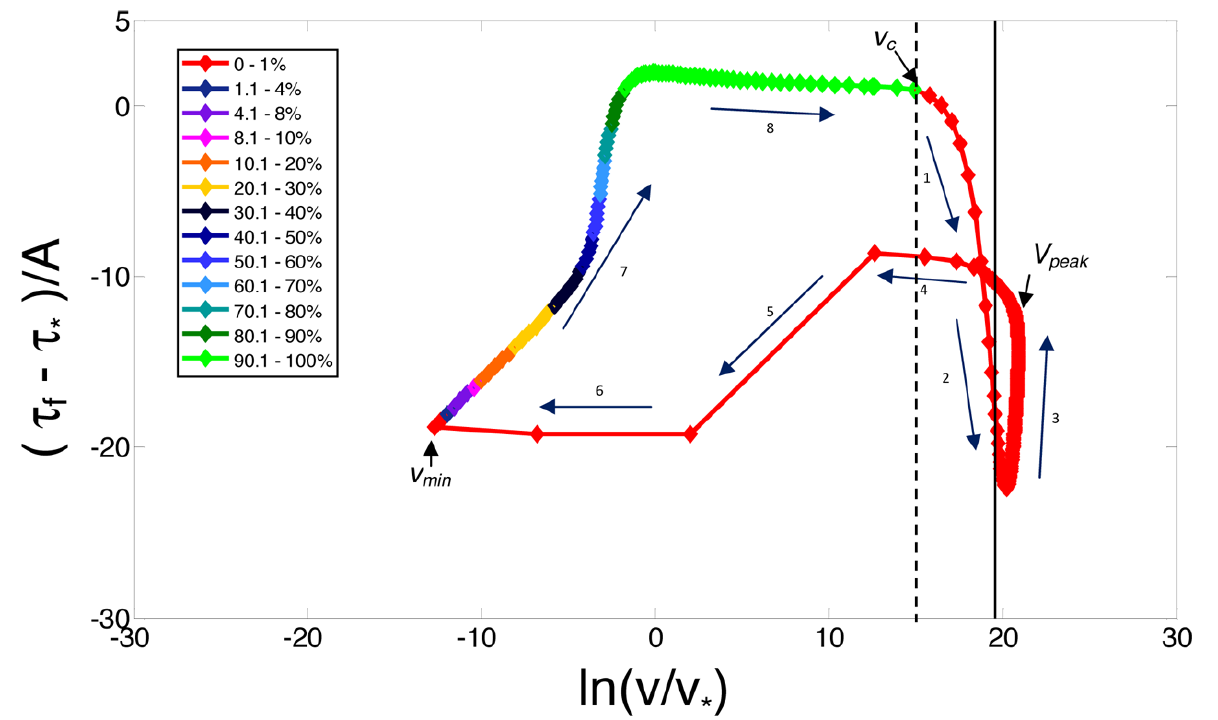
Figure 6. Single limit cycle resulting from the CH law and with the RDT. The parameters are those of Table 1. The colors express the relative duration of each single phase with respect to the total duration of the cycle. The count begins from the point marked by the symbol v / v ) = 12.7; continuous black line, ln( v Dashed black line, ln( v c *